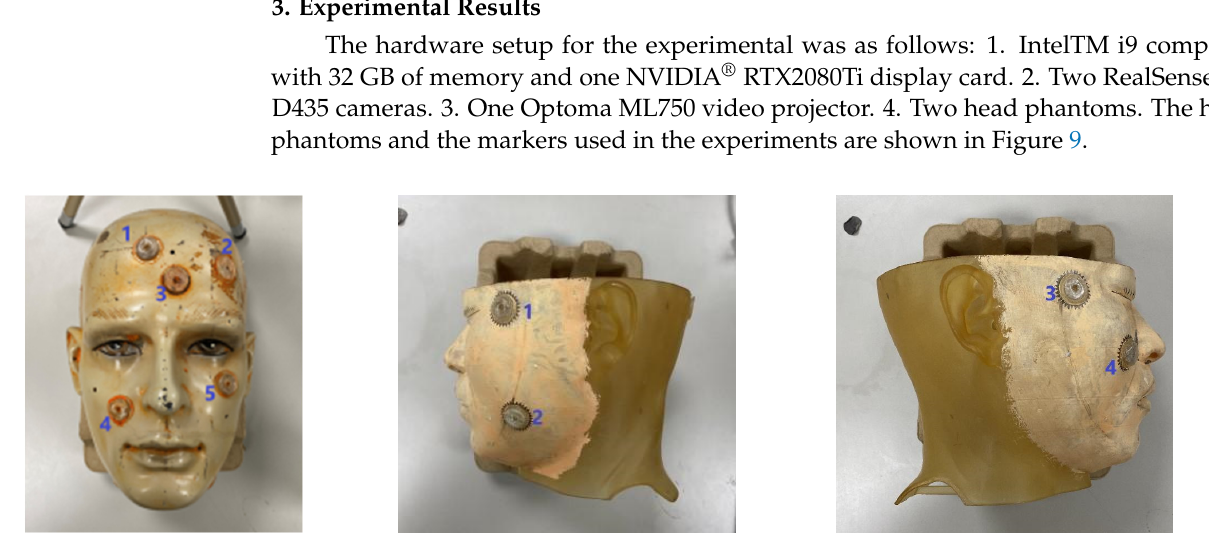
Figure 8. Flowchart of the process of projecting image onto the skin surface of a patient.